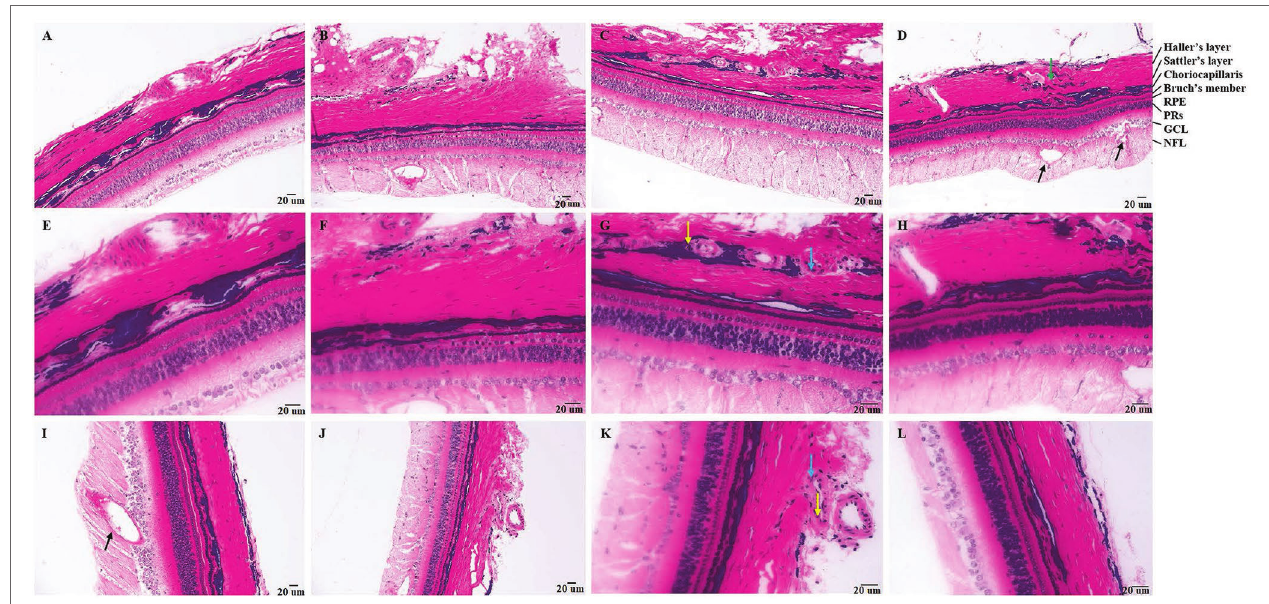
FIGURE 1 | Pathology of tree shrews with choroidal neovascularization (CNV). [ A and B (200×), E and F (400×)] Pathology of tree shrew CNV after 7 days of laser photocoagulation. [ C and D (200×), G and H (400×)] Pathology of tree shrew after CNV 14 days of laser photocoagulation. [ J (200×), I and K (400×)] Pathology of tree shrew CNV after 21 days of laser photocoagulation. [ L (400×)] Intact retina and choroid with clear structure of normal tree shrew. The yellow arrow indicates neutrophils, the blue arrow indicates macrophages, the black arrow indicates neovascularization, and the green arrow indicates loose haller’s and sattler’s layer in